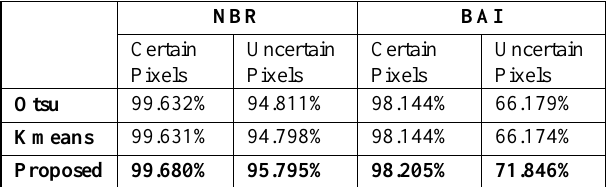
Table 2. OA of different methods on certain or uncertain